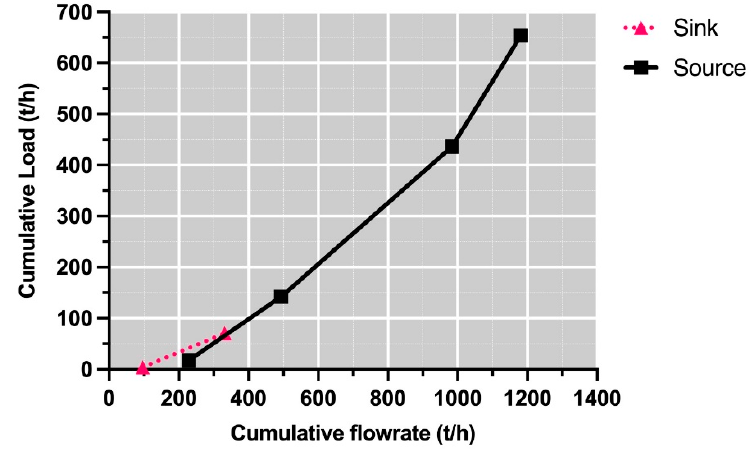
Figure 6. Composite curve for organic cascade.